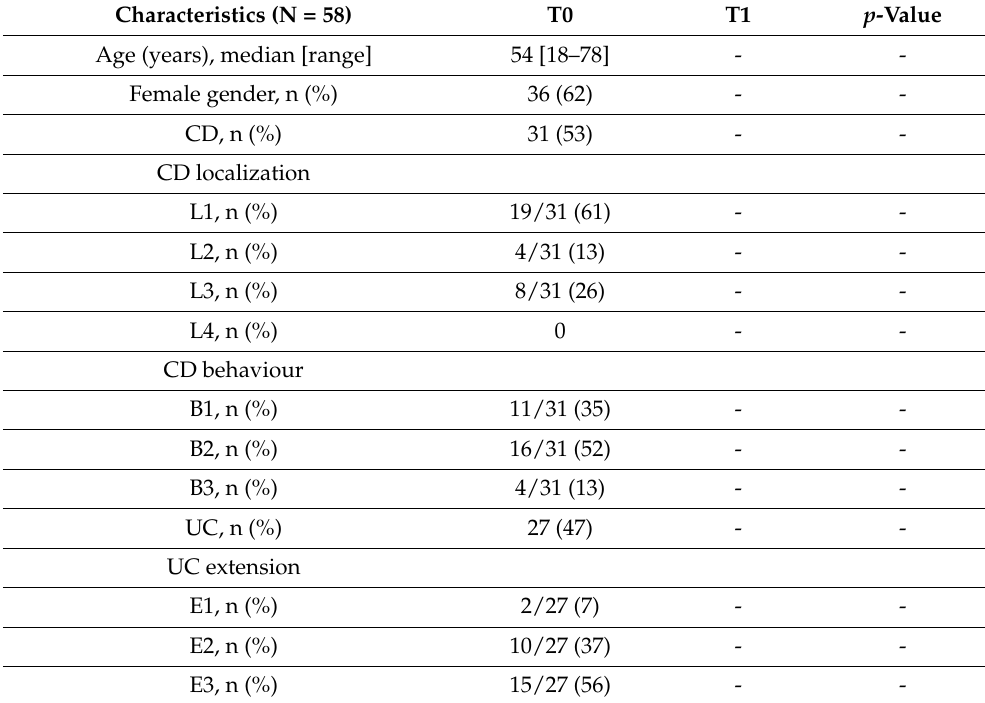
Table 1. Demographic and clinical characteristics of the enrolled patients at baseline (T0) and at the end of the study (T1). CD: Crohn’s disease; UC: ulcerative colitis; BMI: body mass index; EIMs: extraintestinal manifestations; ISS: immunosuppressors. Characteristics (N = 58) T0 Age (years), median [range]